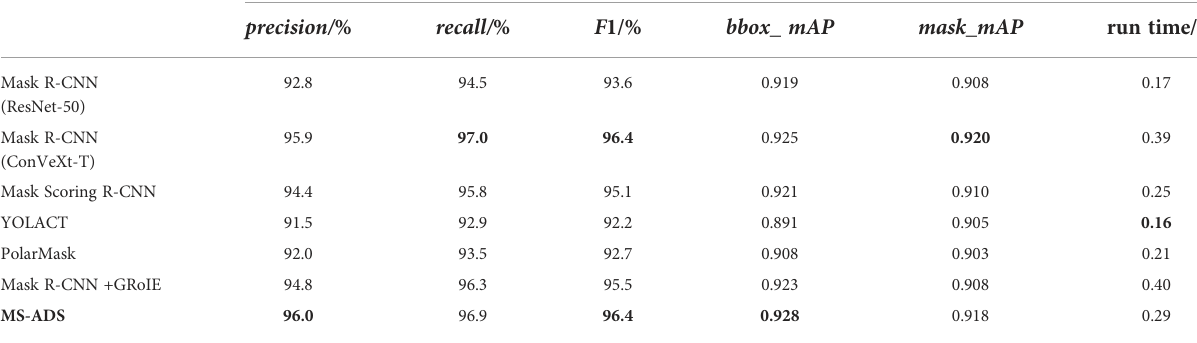
TABLE 5 Detection and instance segmentation results of seven methods. Methods